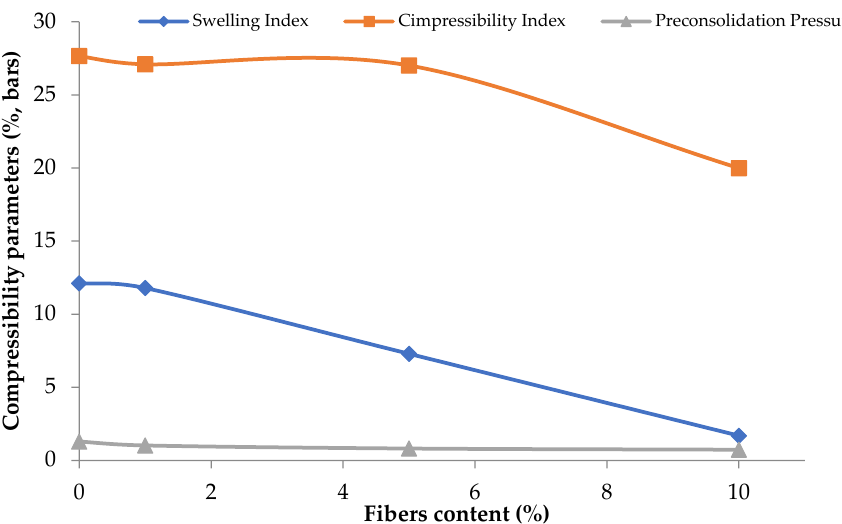
Figure 13. Variation of compressibility parameters as a function of the percentage of Diss fibers.